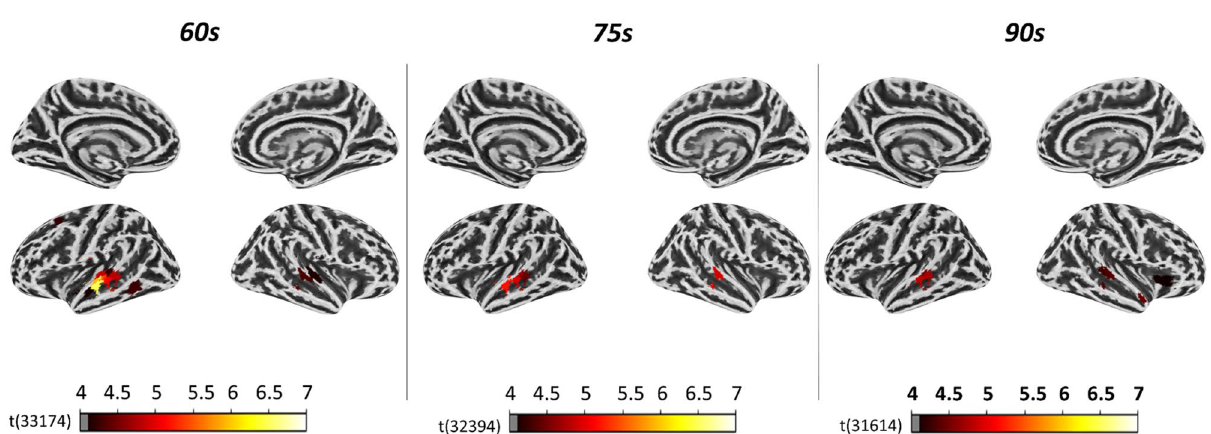
Figure 2. Regional statistical map of the contrast FW versus BW projected on a surface in the standard MNI space (left and right hemisphere). Color-coded areas indicate the atlas’ parcellations that yielded a significantly higher correlation with the surprisal predictor in the FW speech condition compared to the BW speech condition ( p < 0.05, Bonferroni corrected). A left lateralized regional pattern, encompassing parcellations mainly in the temporal and frontal areas, was observed for all the time windows. Consistently across the time windows, the highest statistical values were observed in parcellations located in the left superior/middle temporal gyrus.